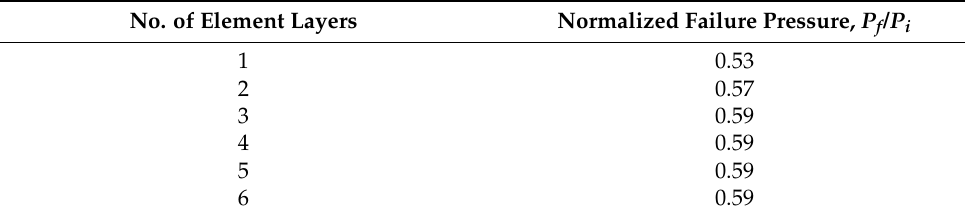
Figure 4. Meshed pipe model and constraints imposed. Table 3. Results of mesh convergence study.